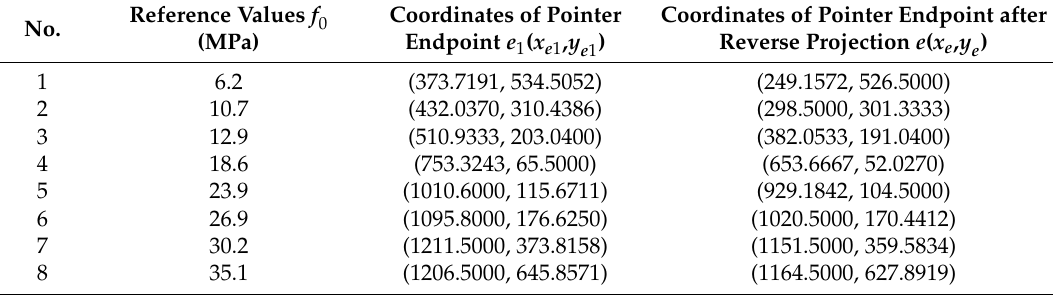
Figure 7. ( a ) illustration of pointer meter plane before Reverse Projection; ( b ) illustration of pointer meter plane after Reverse Projection. Table 2. Comparison for the pixel coordinates of pointer meter plane after Reverse Projection.